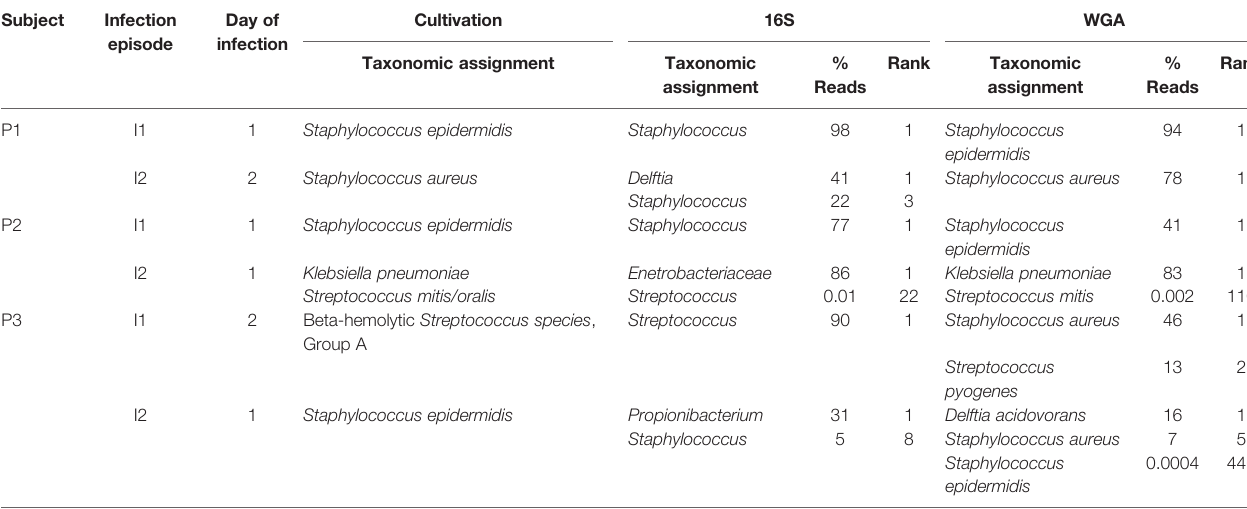
TABLE 1 | Comparison of taxonomic assignments of bacteria by microbiology lab culture, 16S, and WGA for 6 samples that were culture-positive.